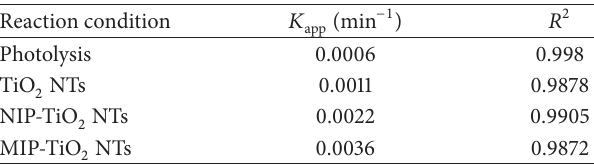
Table 3: Kinetic data for direct photolysis and photocatalytic degradation of PFOA.